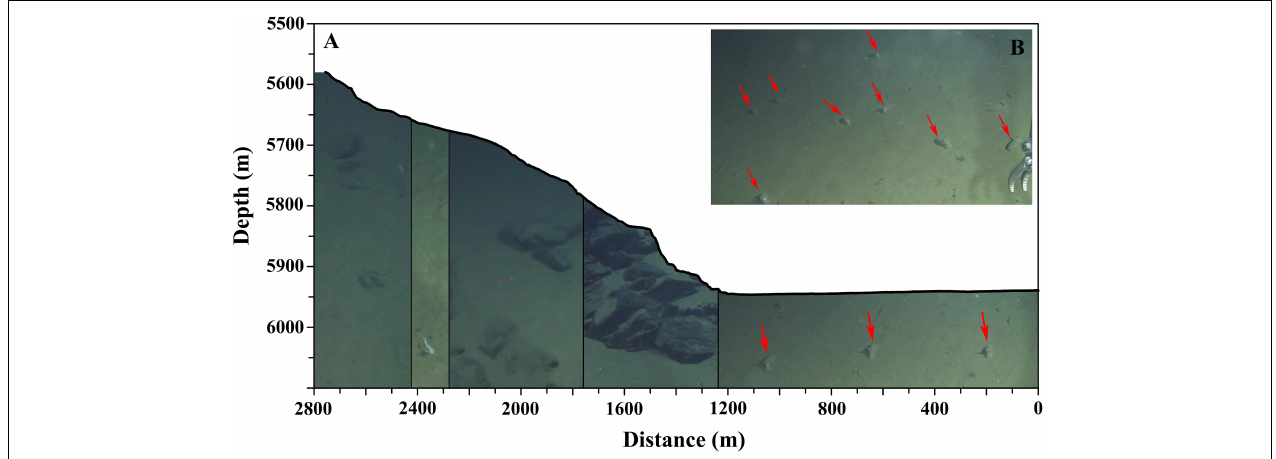
FIGURE 10 | (A) survey profile of D110, pictures indicate different types of substrates; (B) several holothuroids in one frame. Red arrows indicated deposit-feeding elpidiids.